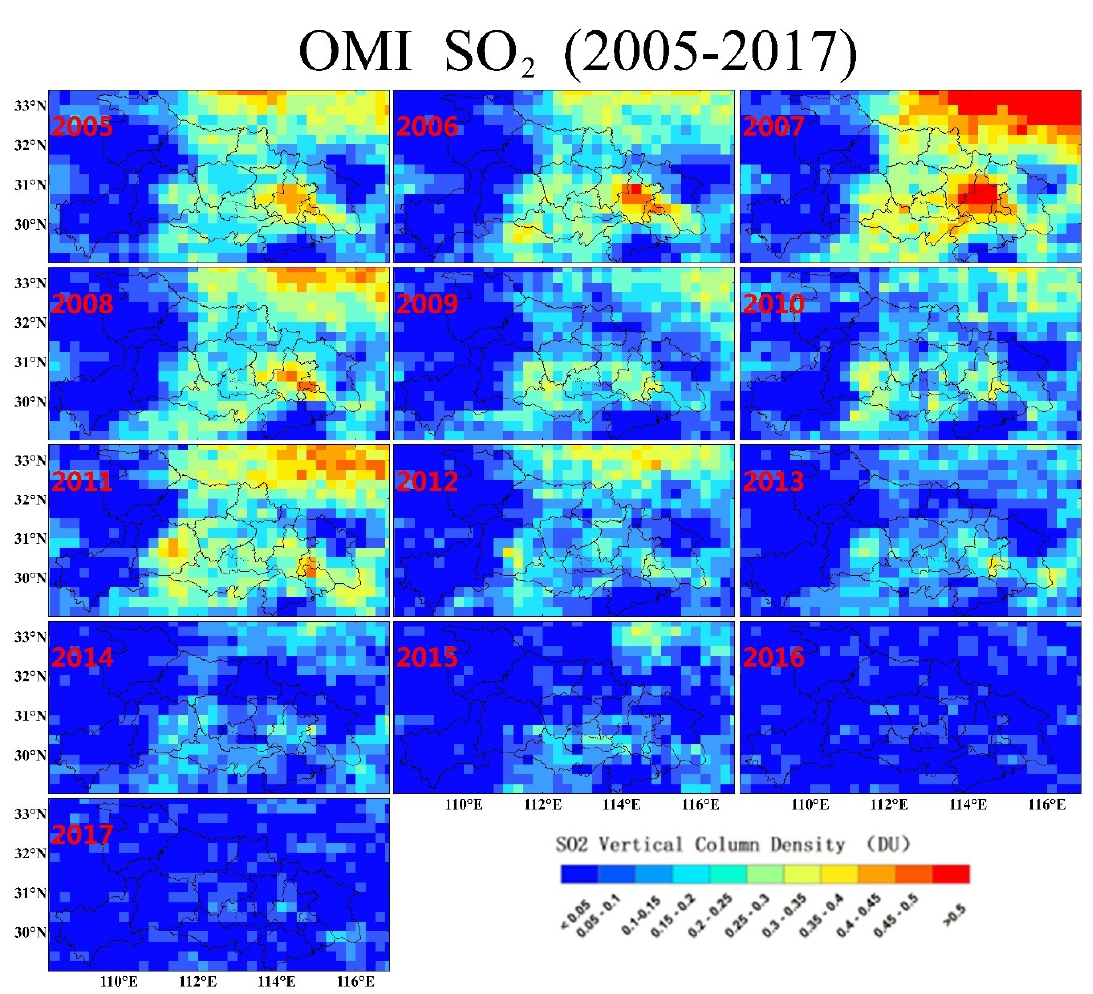
Figure 3. Spatial and temporal distribution of annual ozone monitoring instrument (OMI), sulfur dioxide (SO 2 ), and vertical column density (VCD) over Hubei province during 2005–2017.